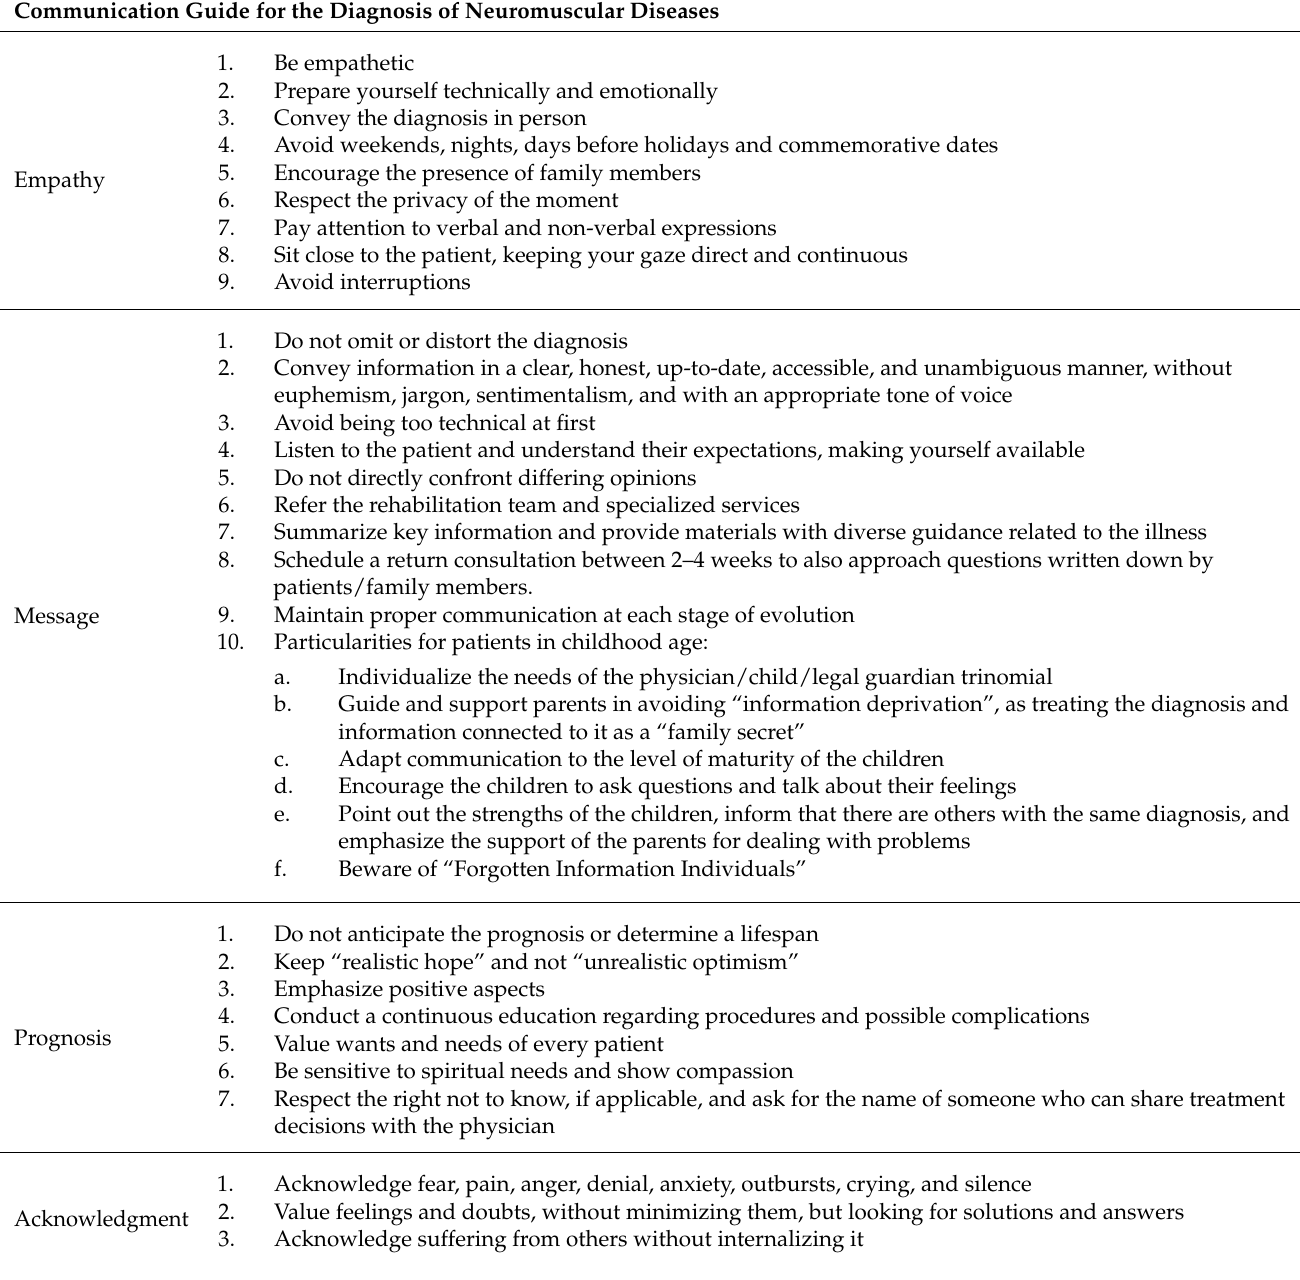
Table 3. EMPATIA Communication